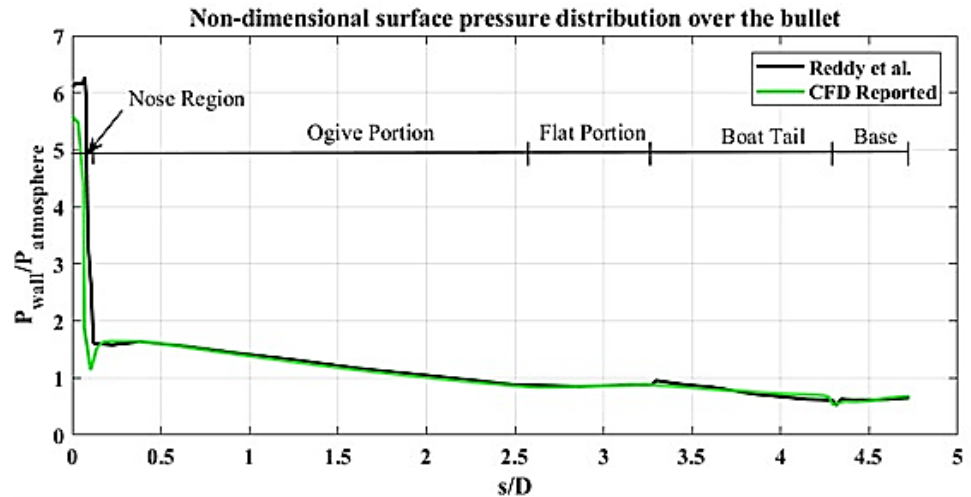
Figure 4: Validation plot comparing surface pressure distribution over the bullet